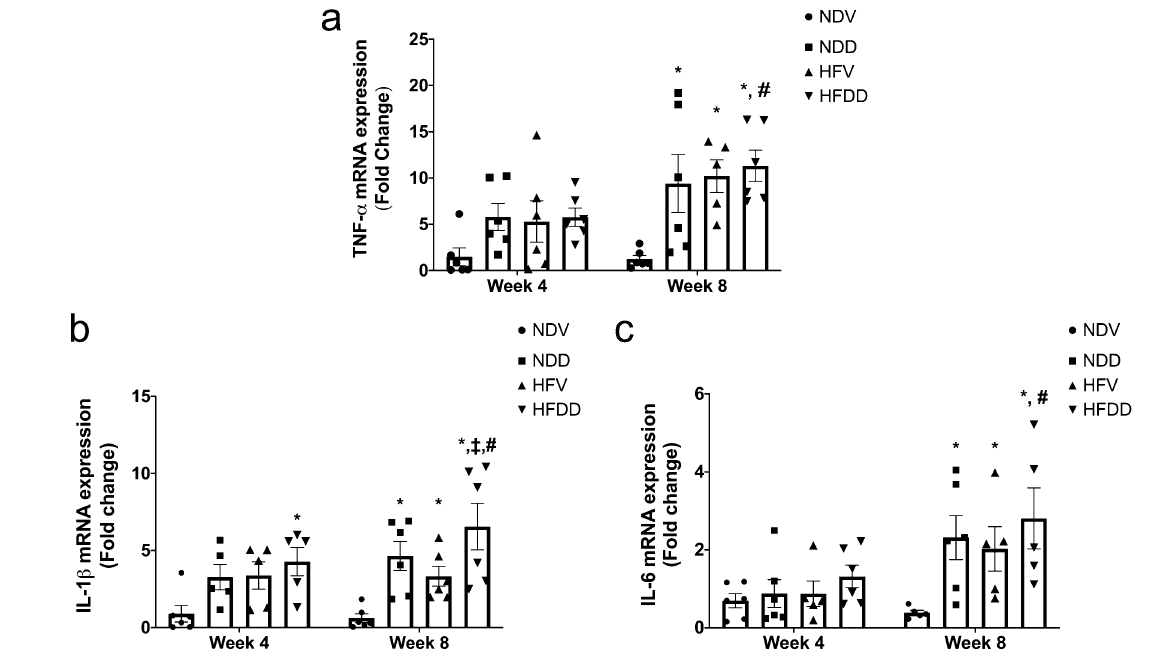
Figure 3. D-galactose-induced aging aggravated bone inflammation in the obese-insulin resistant condition. ( a ) TNF-α mRNA expression in bone tissues at the indicated time points, ( b ) IL-1 β mRNA expression in bone tissues at the indicated time points, ( c ) IL-6 mRNA expression in bone tissues at the indicated time points. Bar graphs are presented as mean ± SEM (n = 5–6/group). * p < 0.05 versus NDV at the same time point, † p < 0.05 versus NDD at the same time point, ‡ p < 0.05 versus HFV at the same time point, # p < 0.05 versus same group at the different time point. HFDD, high-fat diet with D-galactose; HFV, high-fat diet with vehicle; IL-1 β, interleukin-1β; IL-6, interleukin-6; NDD, normal diet with D-galactose; NDV, normal diet with vehicle: TNF-α, Tumor necrosis factor